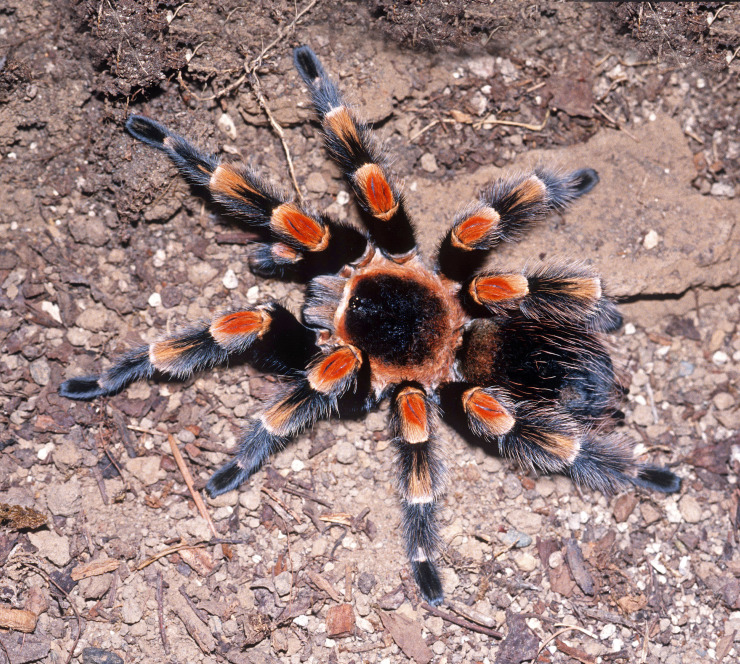
Brachypelma
smithi (F.O.P.-Cambridge, 1987) male dark morphotype from north of Ixtapa, Guerrero state, Mexico. Photo: Rick C. West.